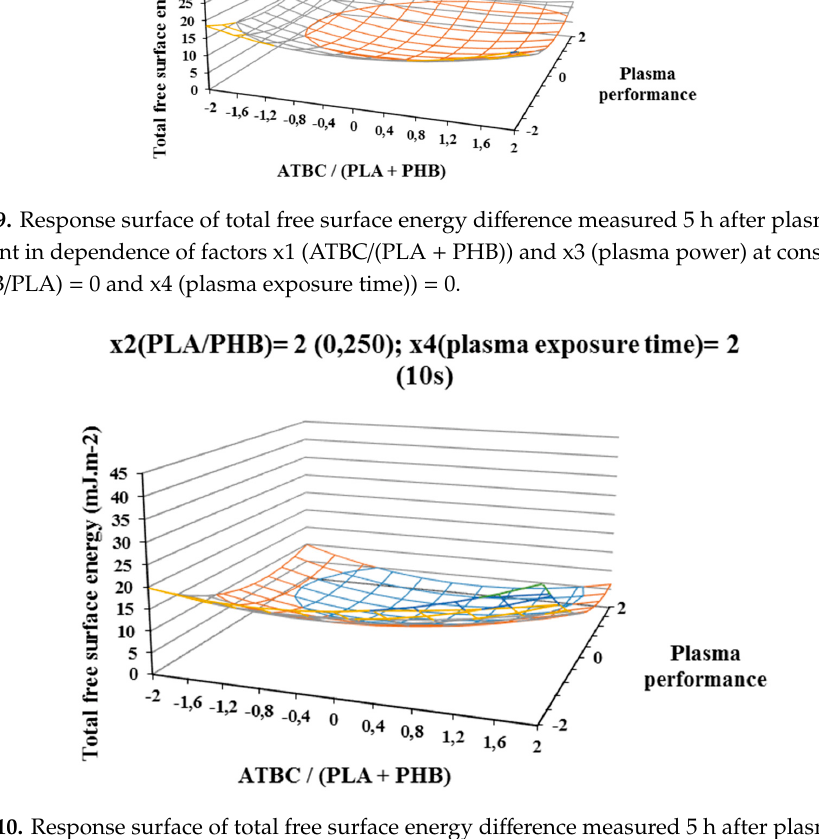
Figure 10. Response surface of total free surface energy difference measured 5 h after plasma surface treatment in dependence of factors x1 (ATBC/(PLA + PHB)) and x3 (plasma power) at constant factor x2 (PHB/PLA) = 2 and x4 (plasma exposure time)) = 2.